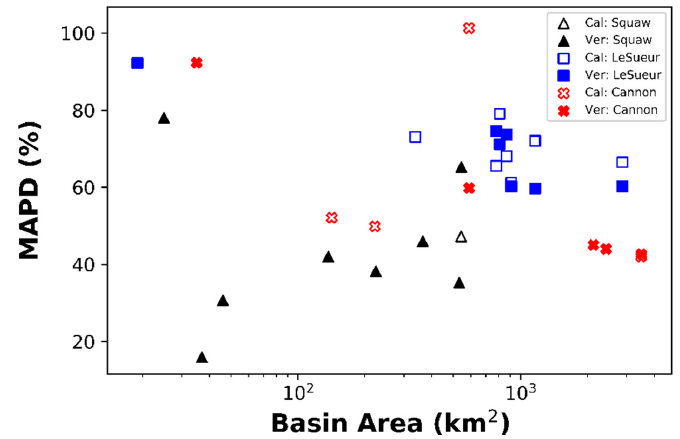
Figure 4. Mean absolute percent deviation (MAPD) versus basin area (plotted on a log scale) for all watersheds and subwatersheds for the calibration (Cal) and verification (Ver) periods for simulated discharge produced from Stage IV inputs. Table 6. Percent bias (Pbias), coefficient of determination (R 2 ), Nash-Sutcliffe efficiency (NSE) and mean absolute percent deviation (MAPD) for the calibration (cal) and validation (val) period for model runs using Stage IV forcing. * Denotes basin outlet.